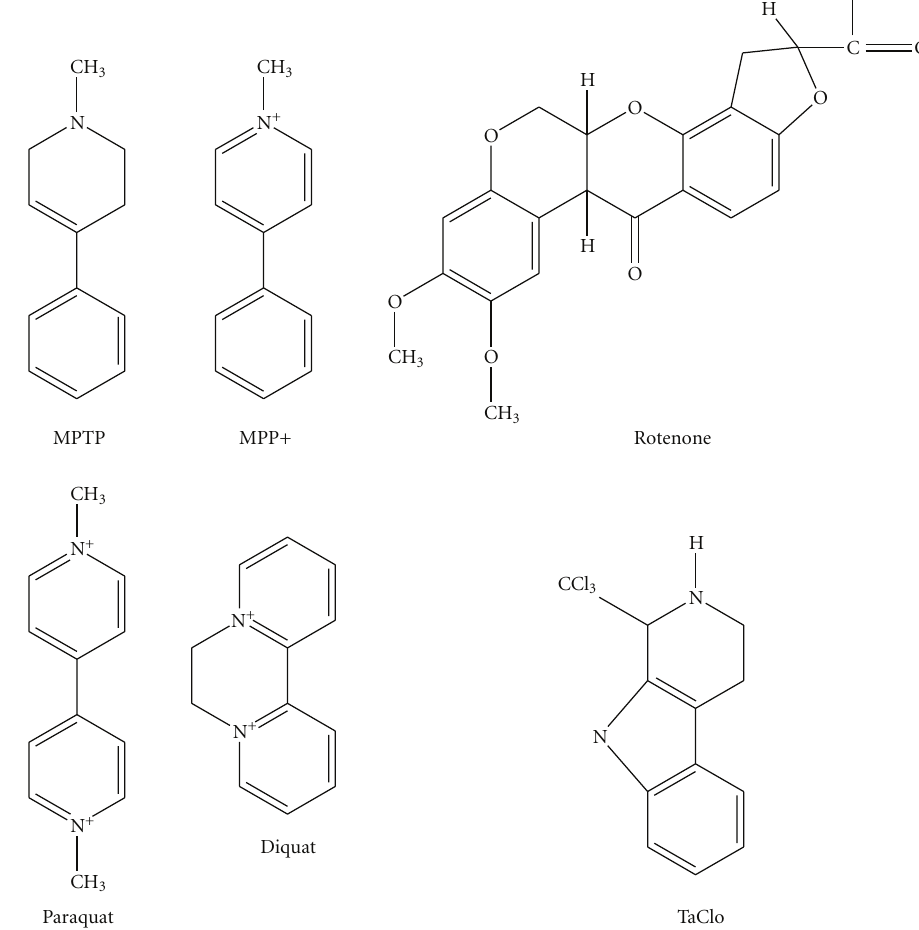
Figure 3: Structures of the PD-linked neurotoxins MPTP/MPP+, Rotenone, Paraquat, Diquat, and TaClo.